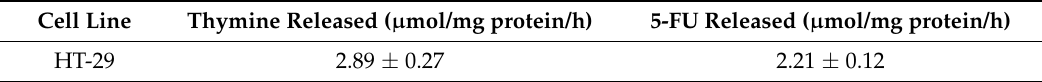
Table 3. TP activity of HT-29 cell lysate, with regard to thymidine and 5’-DFUR phosphorolytic cleavage.